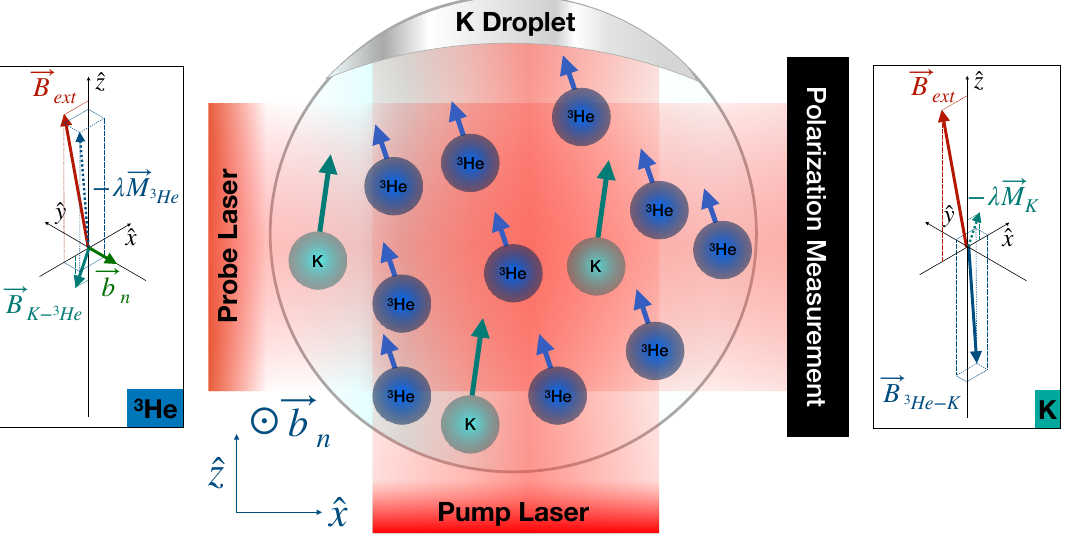
Figure 1 . Center: schematic illustration of the principles of operation of the comagnetometer, including the pump laser, probe laser, polarization measurement, glass cell, K droplet (indicated by the silver sphere), K atoms and 3 He atoms. The pump laser in the ^ z direction polarizes the K atoms, which themselves polarize the 3 He to the ^ z direction. Measuring the outgoing probe laser beam’s polarization allows one to measure the ^ x projection of the alkali spin. In this illustration an anomalous (cid:12)eld ~b n is present (e.g. sourced by an ALP) along the ^ y direction and a(cid:11)ects only the 3 He atoms. Side panels: 3-dimensional axes depicting the spins of the 3 He ( left ) and K ( right ) and the di(cid:11)erent (cid:12)elds (anomalous as well as magnetic). ~B ( ~B 3 ) is the magnetic (cid:12)eld the K K (cid:0) 3 He He (cid:0) K ( 3 He) spins induce on the 3 He (K) atoms. Both atoms are in the presence of an external magnetic (cid:12)eld ~B ext , which has a small deviation from the large, controlled ^ z magnetic (cid:12)eld due to magnetic noise, here assumed in the ^ x axis. The overall magnetization of the K ( 3 He) are depicted by the dotted vectors and marked as (cid:0) (cid:21) ~M K ( (cid:0) (cid:21) ~M 3 ). The tuning of the ^ z component of ~B ext to what He is called the compensation point, ensures that the e(cid:11)ect of the 3 He’s magnetization on the K spins, ~B ~B 3 He , has a projection in the ^ x axis which exactly cancels the e(cid:11)ects of ext on K. The rotation induced by ~b n on the 3 He induces transverse polarization in the perpendicular direction on the K spin. This implies the comagnetometer has sensitivity to anomalous (cid:12)elds, while it is insensitive to regular magnetic noise. See main text for further